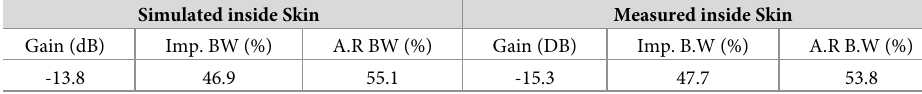
Table 4. At a frequency of 2.45 GHz, both theoretical and experimental findings were